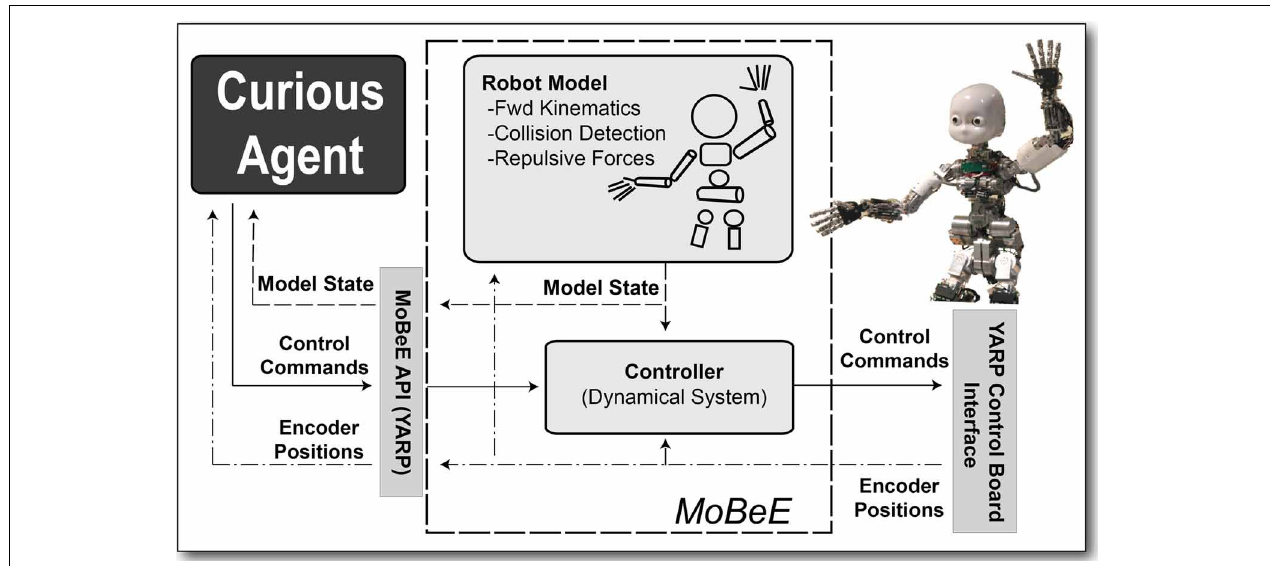
FIGURE 1 | MoBeE and the iCub. MoBeE (left) prevents the iCub humanoid robot (right) from colliding with the table. Semi-transparent geometries represent force fields, and when these